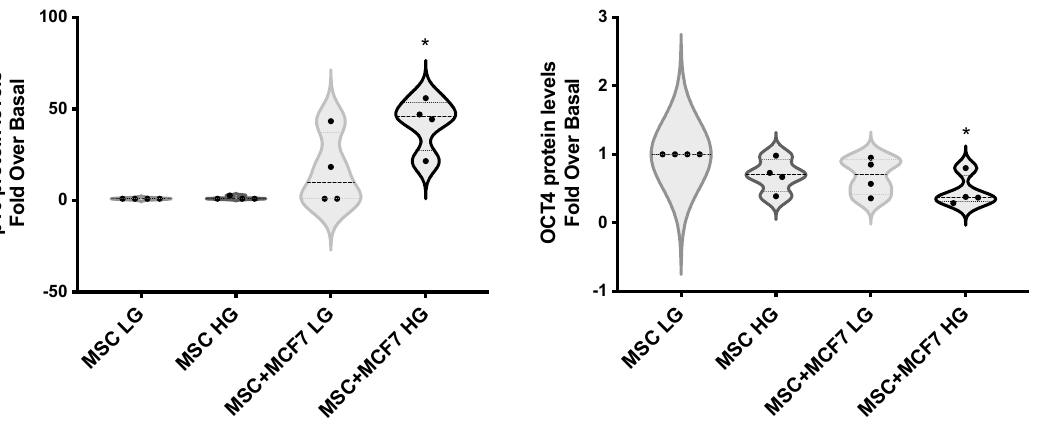
Figure 7. Effect of glucose on MAT-MSCs and MCF7 crosstalk in 3D organoids. Three-dimensional cultures were set up by using MCF7 and MAT-MSCs (ratio 4:1) in LG or HG concentrations. After 72 h, spheroids were mechanically disaggregated and cells were stained with PE-anti-OCT4, PE-anti- NANOG, PE-anti- α -SMA, APC-anti-FAP and APC-anti-p16, as well as dye/isotype matched antibod- ies for FACS analysis. Results were reported as violin plot of 4–9 independent experiments showing protein levels of ( a ) Oct4 and Nanog in MCF7 or ( b ) α -SMA, FAP, p16 and OCT4 in MAT-MSCs as fold over basal (MCF7 LG/MSC LG). Data were analyzed using the non-parametric Friedman test followed by Dunn’s correction for multiple comparisons. * denotes statistically significant values compared with MCF7 LG or MSC LG (* adjp < 0.05; ** adjp < 0.01, **** adjp < 0.0001).